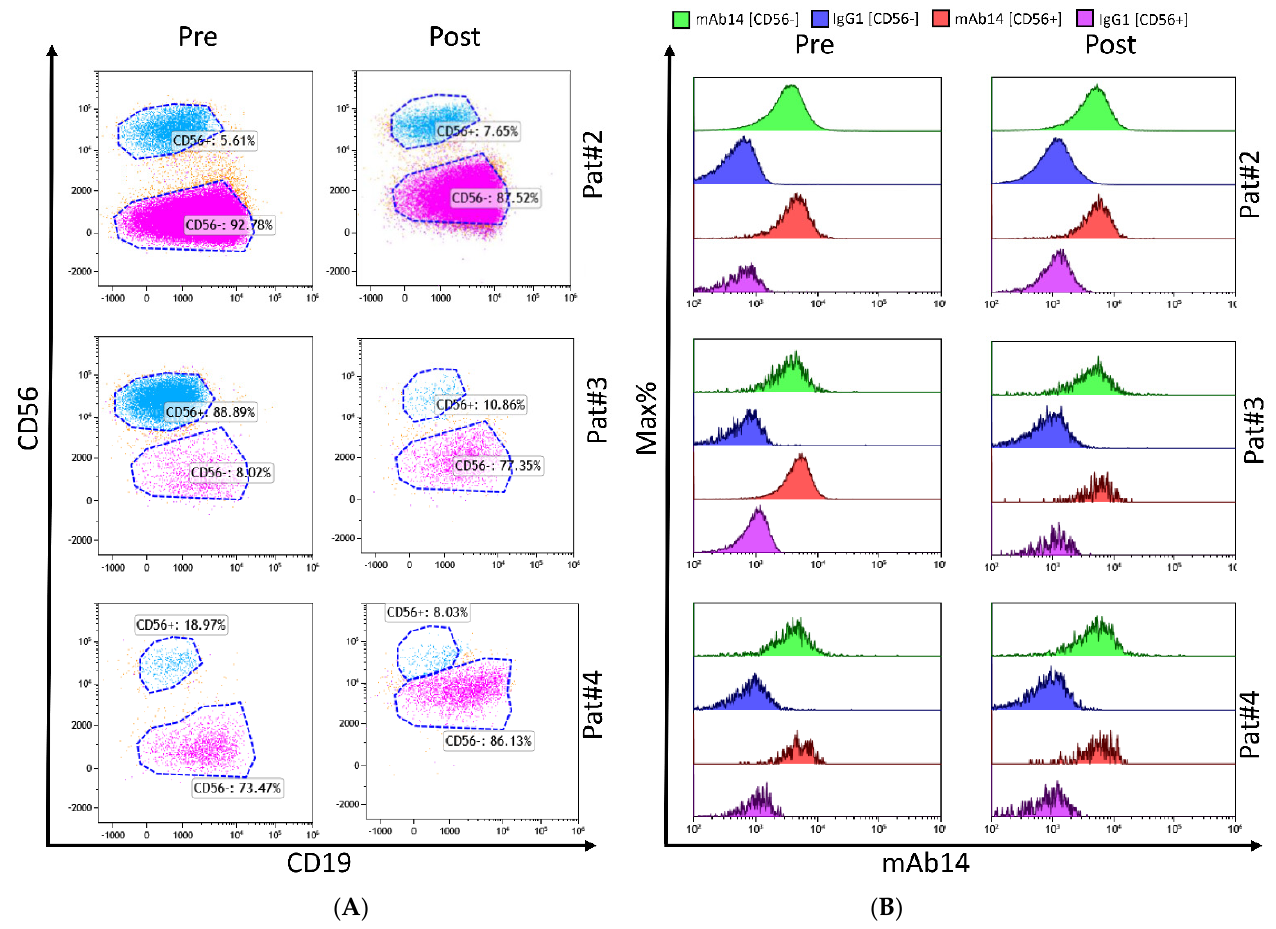
Figure 3. PCNA is expressed on CD38 + CD138 + cells from BM mononuclear cells of MM patients, pre- and post-treatment. For three MM patients (Pat#2, Pat#3, and Pat#4), plasma cells were gated as CD38 + CD138 + and then further dissected by CD56 and CD19 expression. Surface PCNA expression was assessed as a histogram on the CD56 + CD19 - and CD56 - CD19 + subpopulations before (Pre, left) and after (Post, right) treatment. ( A ) Dot plots delineating CD56 + (blue) and CD56 - (purple) MM cells. ( B ) Overlay histograms of surface PCNA staining (mAb 14-25-9, green and red) compared to the control staining (hIgG1, blue and purple) for both subpopulations (CD56 +/ − ). Note that Mab 14-25-9 employed in this staining was chimeric 14-25-9 in which murine Fc was replaced with human IgG1 Fc to allow multicolor staining with directly labeled murine Abs against CD138, CD38, CD56, and CD19. DAPI was used to discriminate against dead cells. Data is shown from three independent biological replicates. Analysis and plots were done using Kaluza software.